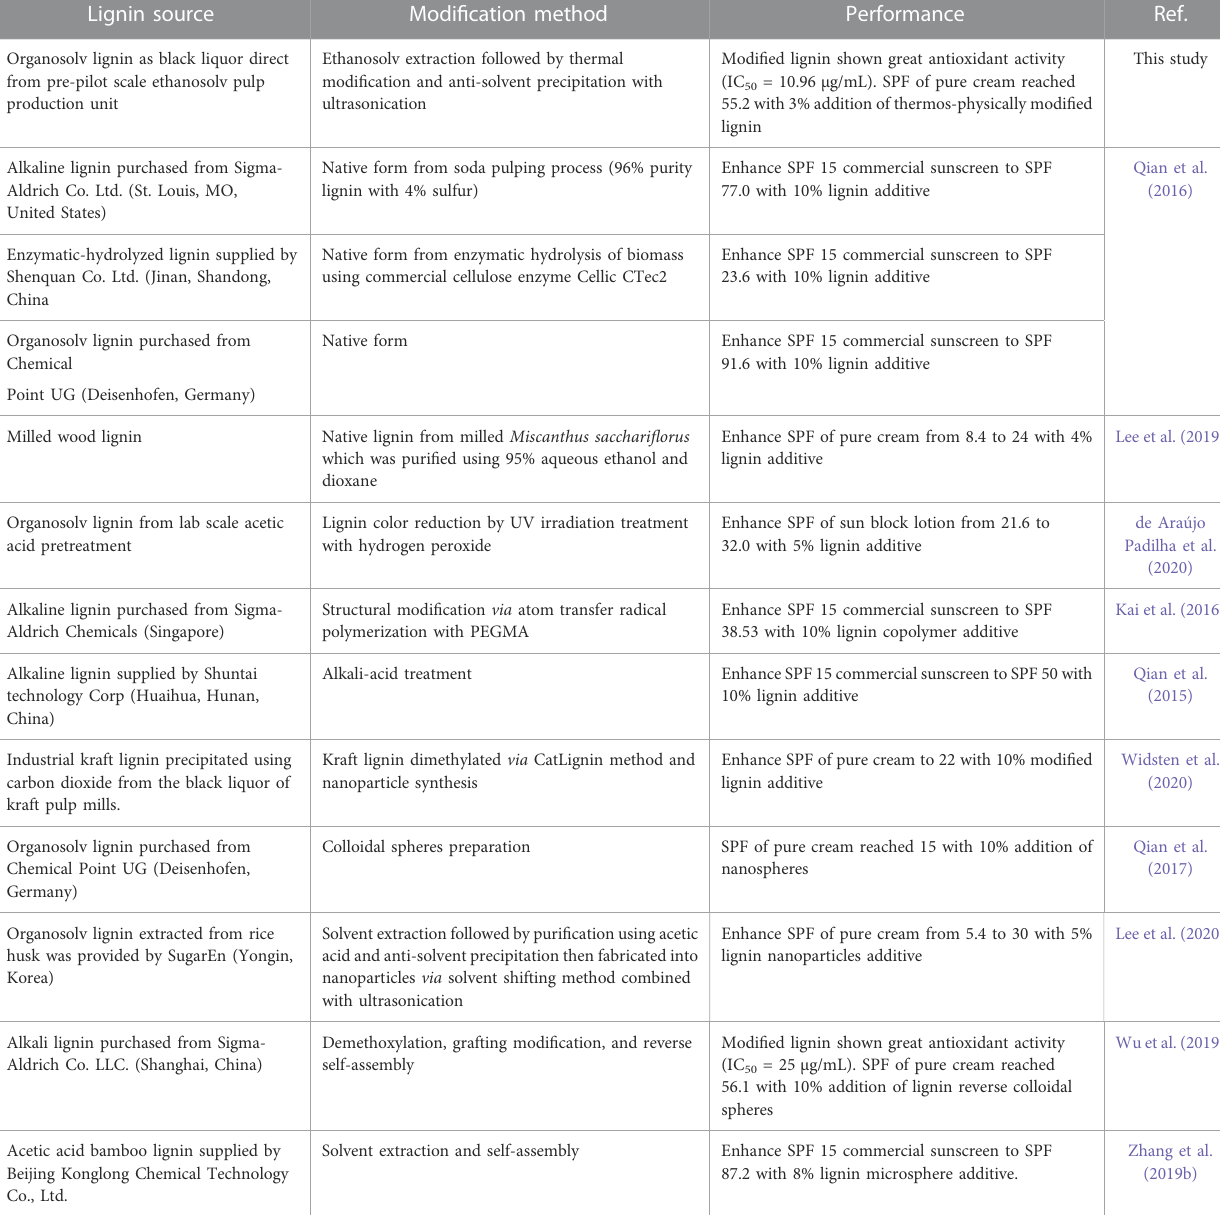
TABLE 4 Summary of current study and other recent research on production of lignin-based cosmeceutical